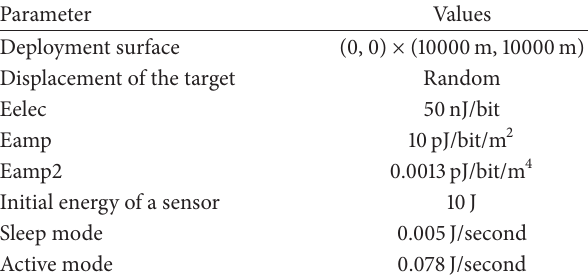
Table 1: The simulation